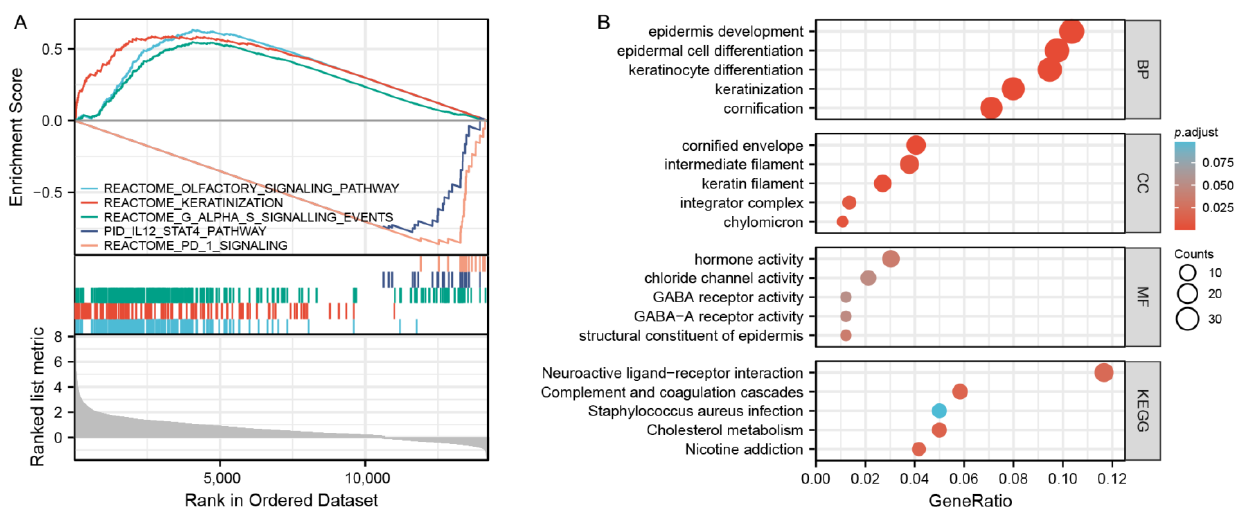
Figure 3. Gene enrichment analysis. ( A ) GSEA functional analysis of genes enriched in representative pathways. ( B ) GO and KEGG analysis of DEGs in MAGEA11 low and high expression samples.